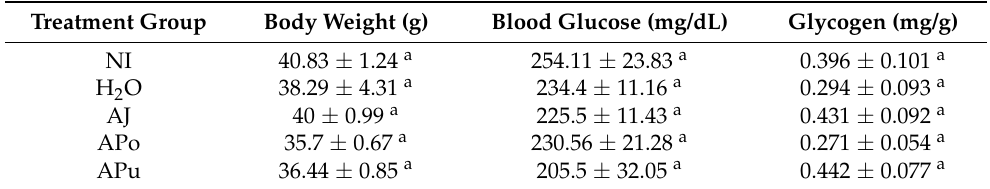
Table 3. Effect of the intra-amniotic administration of apple fraction soluble extracts on body weight (g), blood glucose (mg/dL), and glycogen (mg/g). Treatment